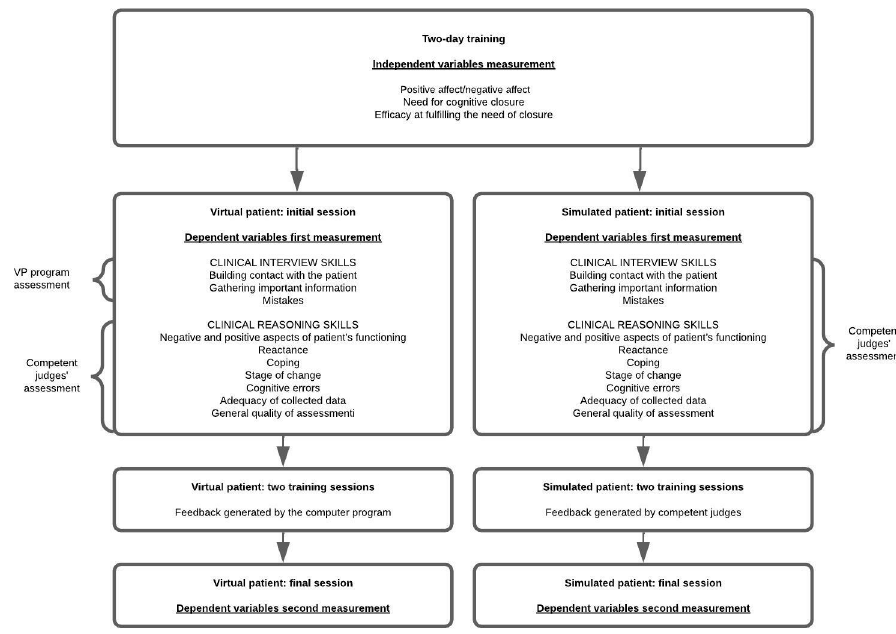
Figure 1. The study procedure.